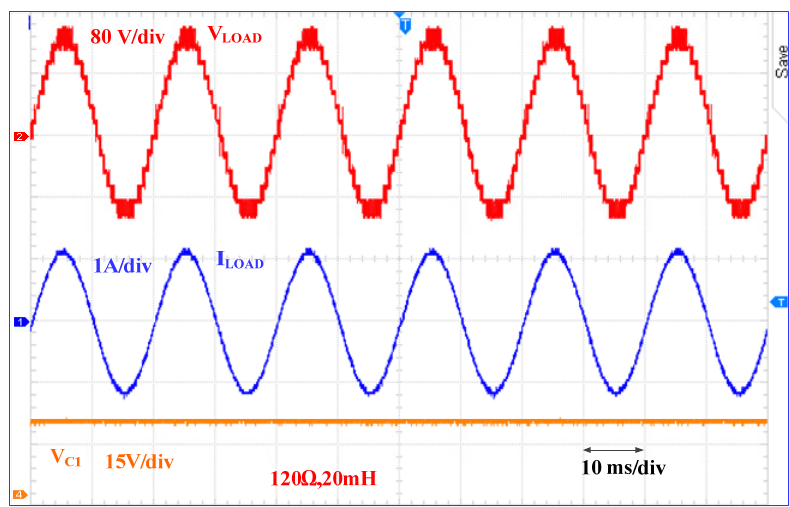
Figure 12. Output voltage, current waveforms and DC link voltage for variable .